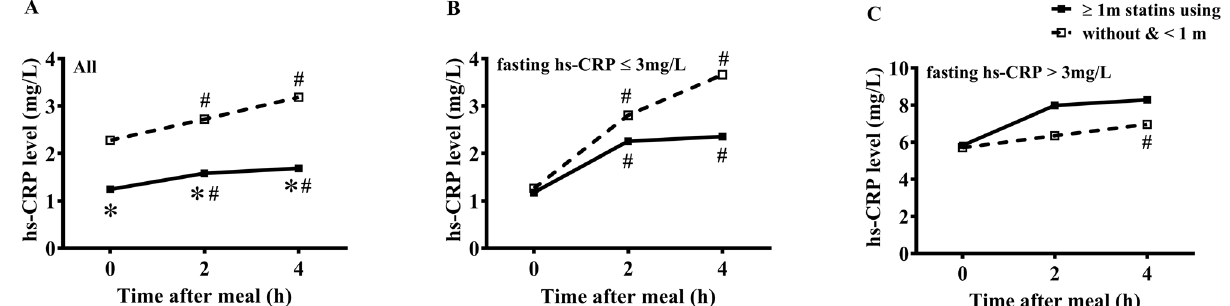
Figure 3. Comparisons of the changes in hs-CRP levels after a daily meal between CHD patients with different terms of statins using. ( A ) Comparisons of the changes in hs-CRP after a daily meal between patients with different terms of statins using in all subjects (i.e., ≥ 1 m statins using, n = 130 vs. without and < 1 m statins using, n = 170). ( B ) Comparisons of the changes in hs-CRP after a daily meal between patients with different terms of statins using in those with fasting hs-CRP level ≤ 3 mg/L (i.e., ≥ 1 m statins using, n = 109 vs. without and < 1 m statins using, n = 103). ( C ) Comparisons of the changes in hs-CRP after a daily meal between patients with different terms of statins using in those with fasting hs-CRP level > 3 mg/L (i.e., ≥ 1 m statins using, n = 21 vs. without and < 1 m statins using, n = 67). * P < 0.05 when compared with CHD patietns without or with statins using < 1 m at the same time point. # P < 0.05 when compared with the fasting level within each